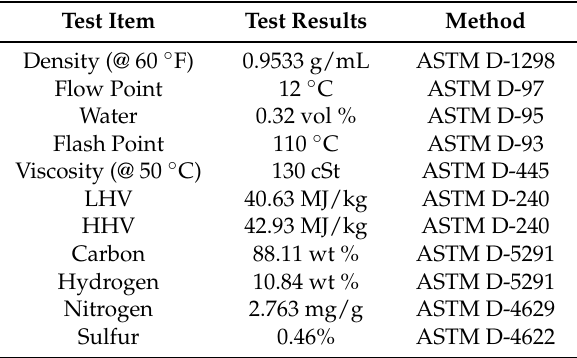
Table 3. Properties of heavy fuel